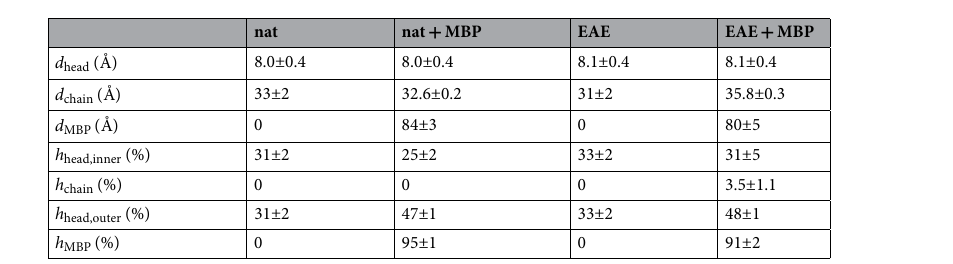
Figure 6. Determination of membrane profile of oriented bilayers by NR. NR data of (a) native and (b) EAE modified membranes with MBP. Each dataset with the 3 contrasts D 2 O , H 2 O and silicon matched water (SMW) have been fitted globally. These fits are indicated by the solid lines in the respective color. Furthermore, the SLD profile of c) native and d) EAE modified membranes with MBP, which is calculated from the fits, is shown. The volume fractions over the distance from the different parts of the membrane are shown e) for the native membrane and f) for the EAE modified membrane.